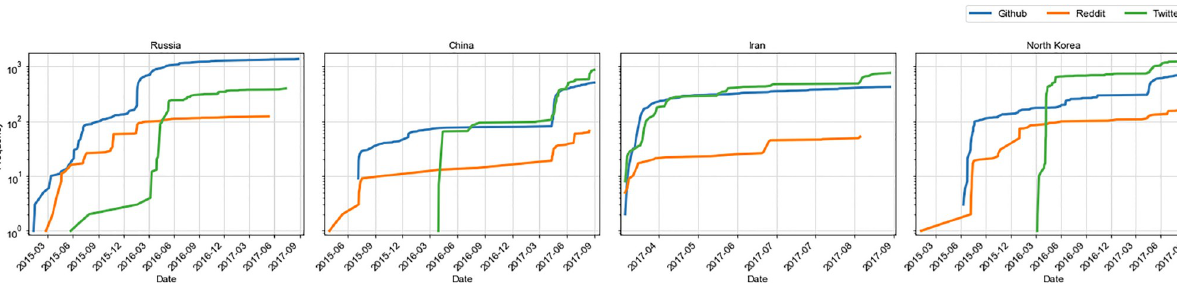
Fig 7. Vulnerability discussion spread across social platforms—GitHub, Twitter, and Reddit for CVEs exploited by country-specific APTs.